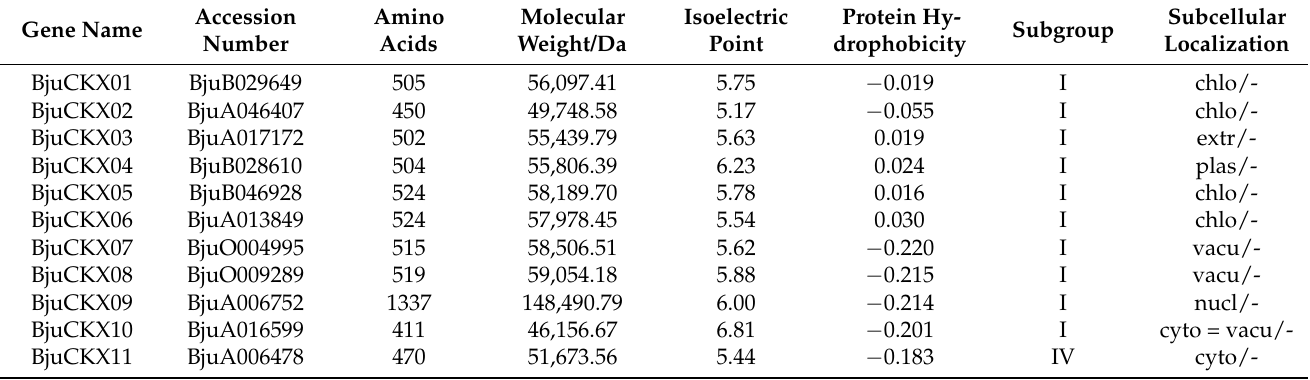
Table 1. Basic information of CKX gene family members of B . juncea